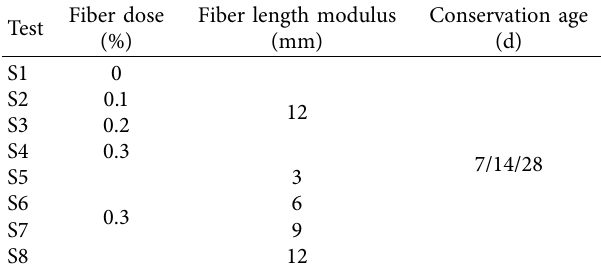
Table 3: Static triaxial test scheme for solidification of remolded soil.